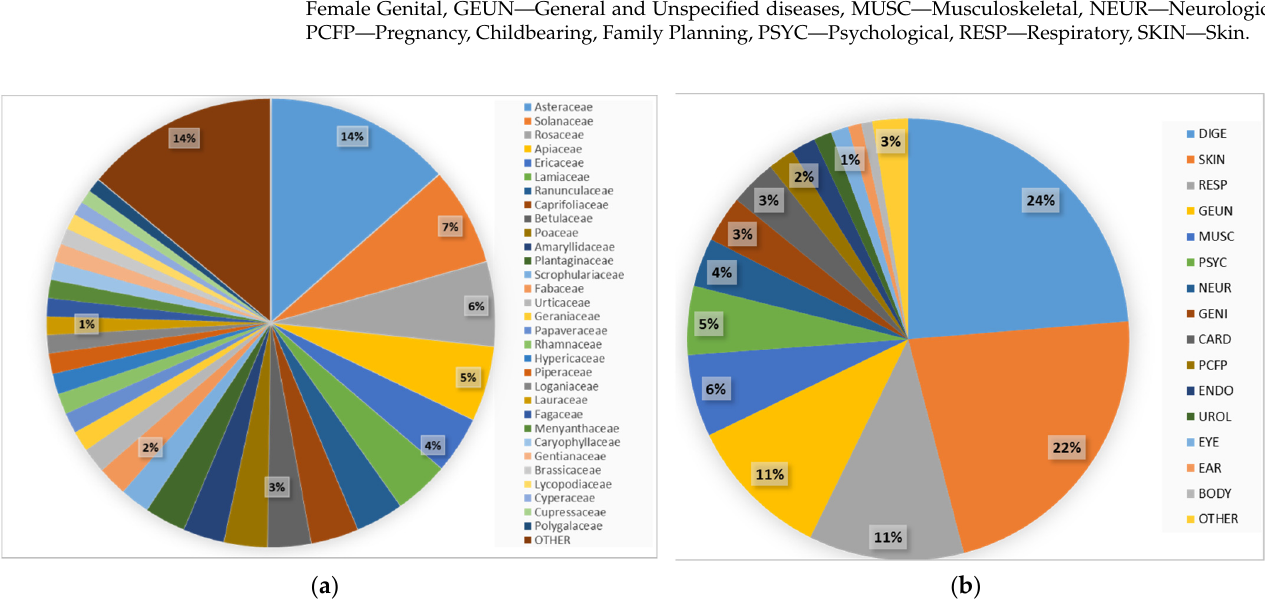
Table 1. Plants named by all three authors and general disease categories.